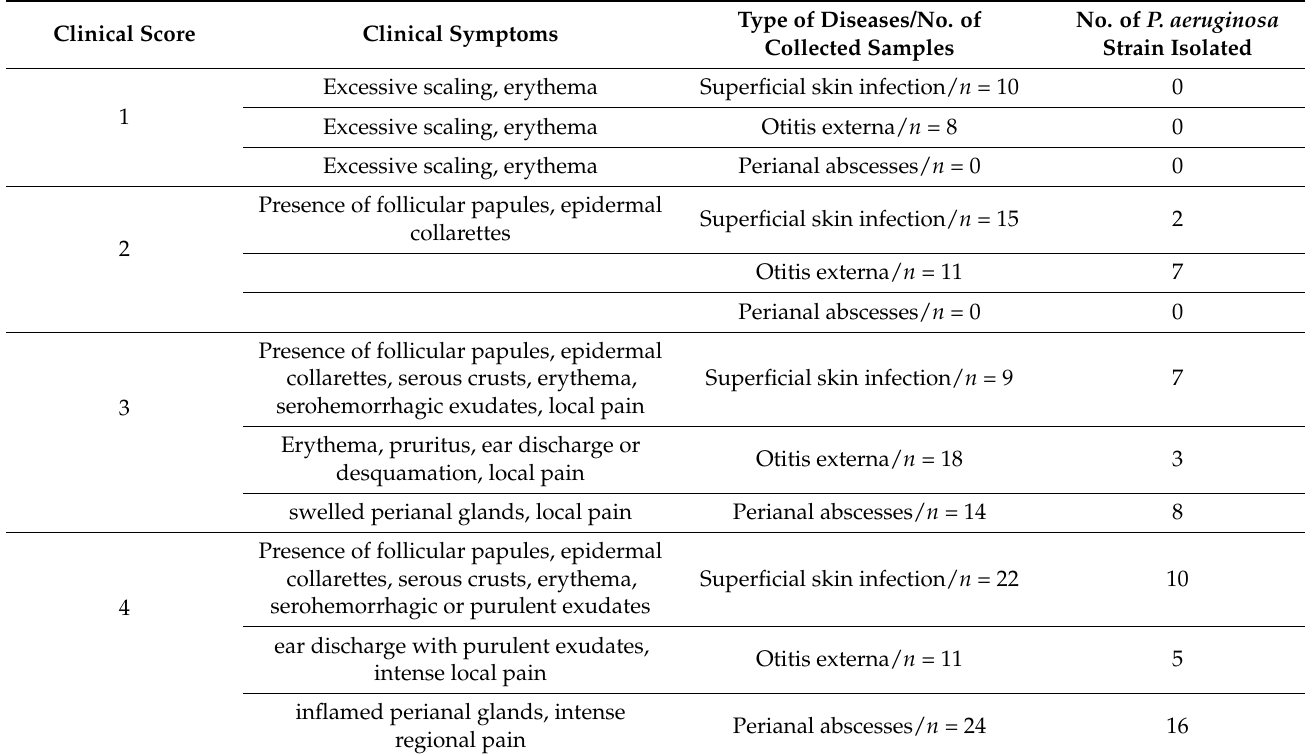
Table 7. Primary criteria for the inclusion of dogs in the study, by the clinical